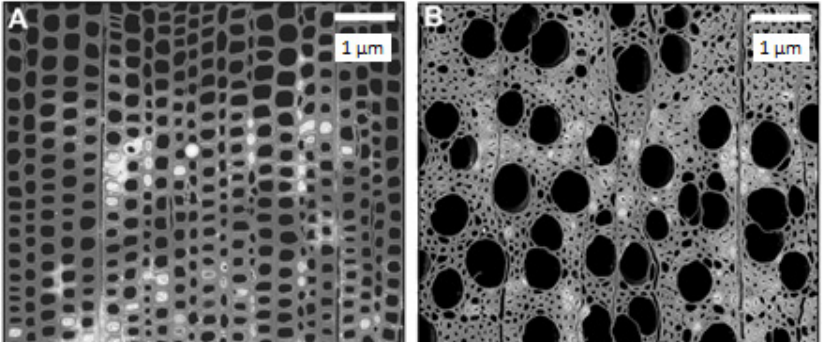
Figure 11. Structure of pine ( A ) and oak ( B ) [20].